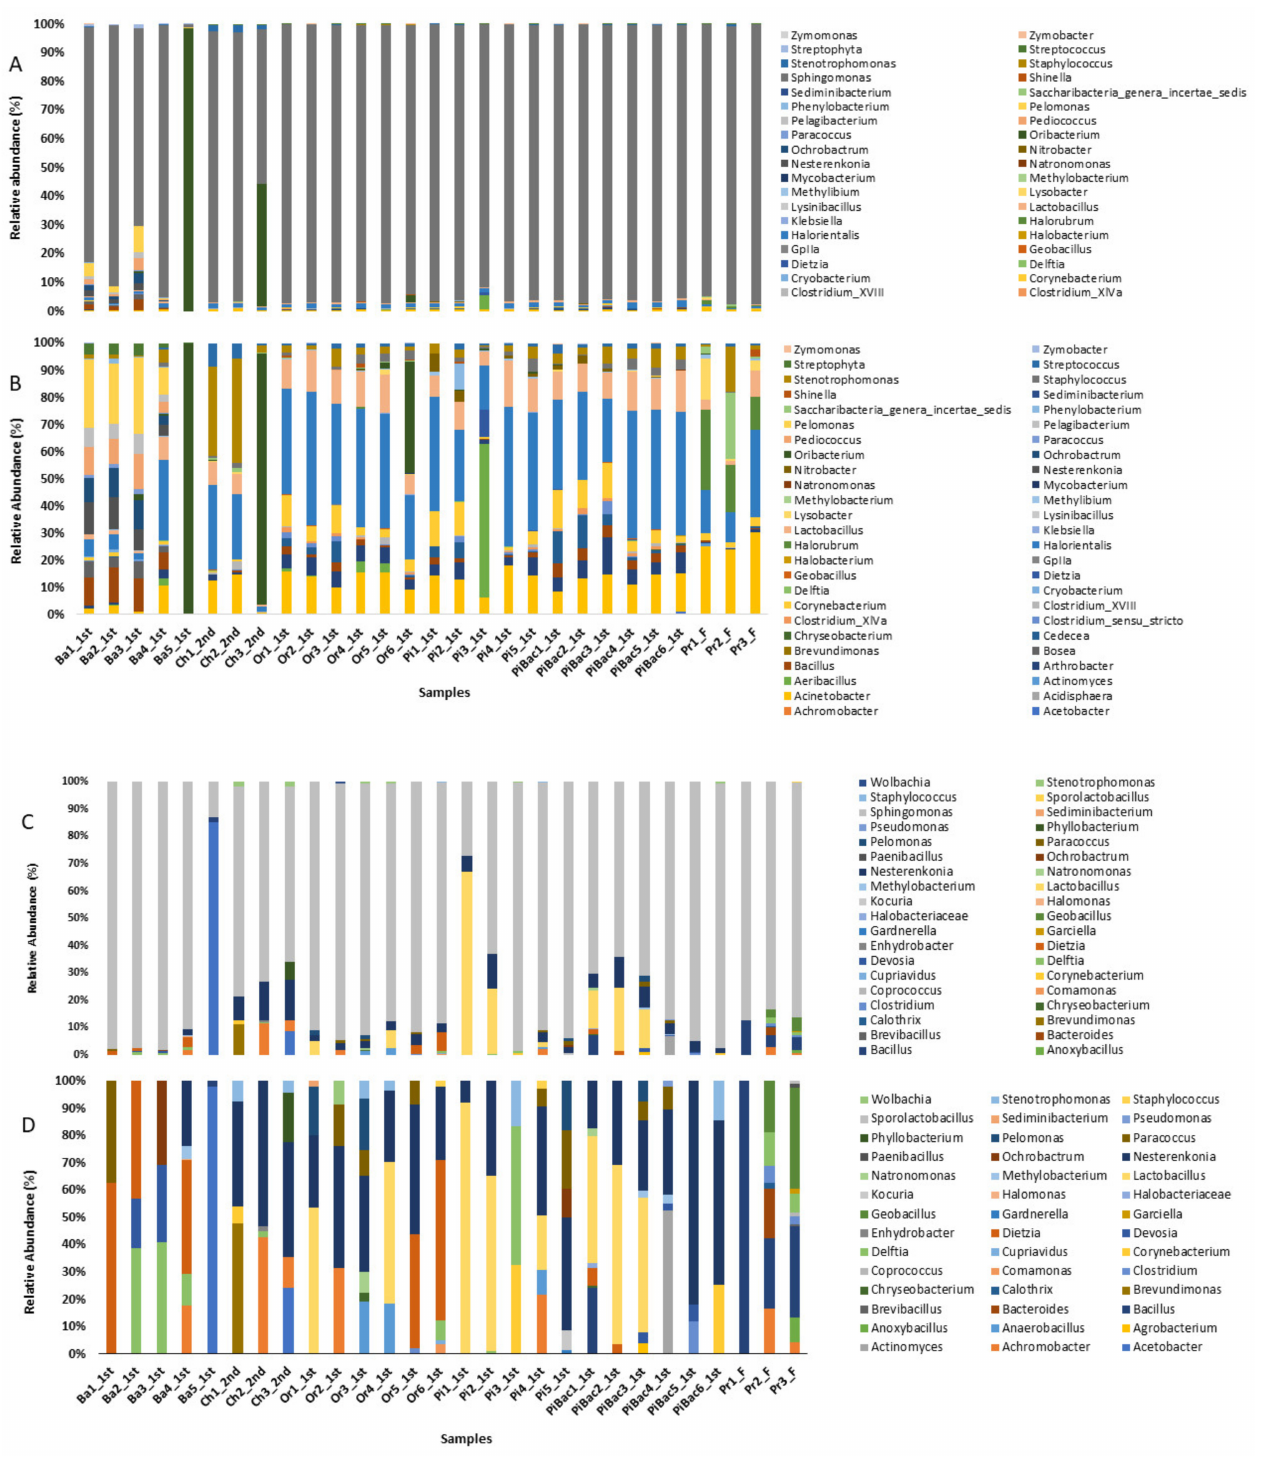
Figure 2. Relative abundance of bacterial diversity at genus level in each fermentation sample using operational taxonomic unit OTU ( A ) and amplicon sequencing variant ASV-based ( C ) taxonomic classifications. The dominant genus Sphingomonas was excluded in both OTU ( B ) and ASV-based ( D ) taxonomic